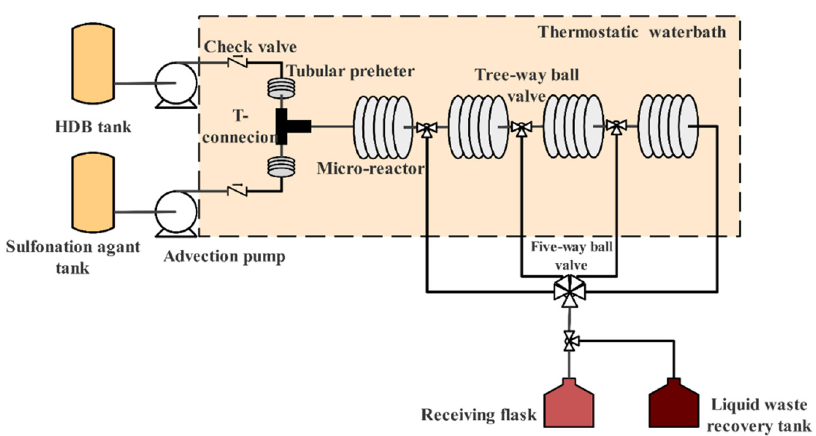
Figure 3: The experimental apparatus is used to study the reaction residence time.